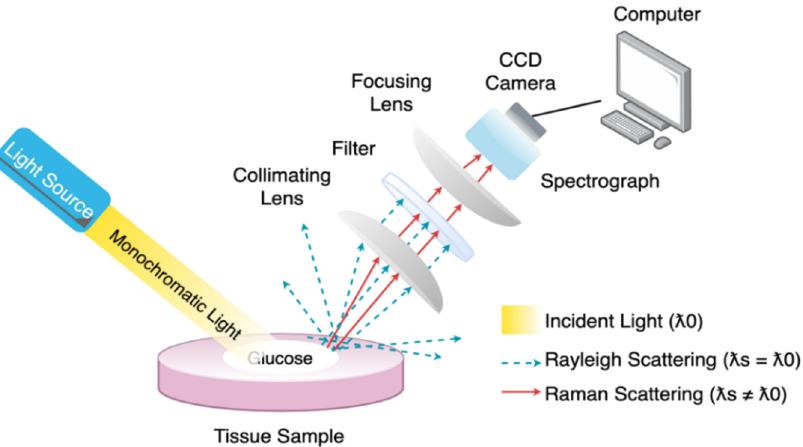
Figure 8. A simplified diagram of Raman spectroscopy where a collimating lens capture part of the scattered radiation and directing it to a filter, so only the Raman scattered light at a wavelength that is different from the incident light to be sensed by the detector. The computer processes the signal and provides the corresponding Raman shift. Redrawn from reference [5].